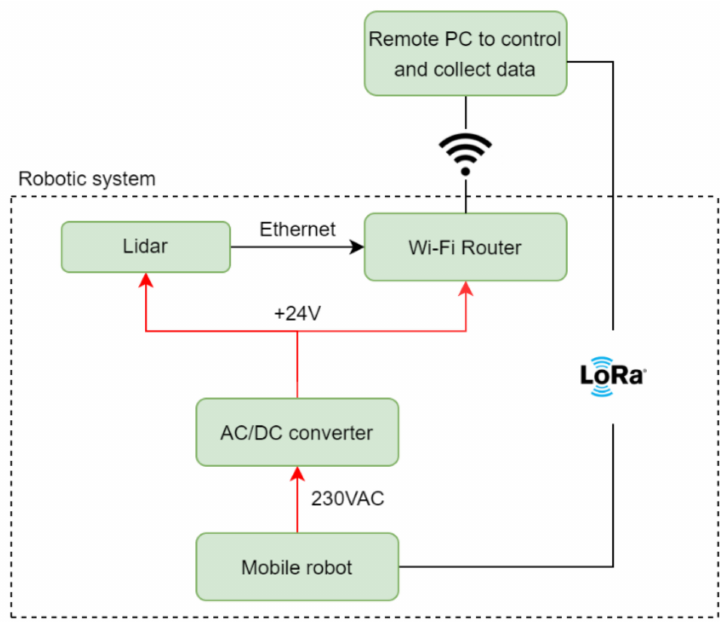
Figure 1. A robotic system with omnidirectional chassis